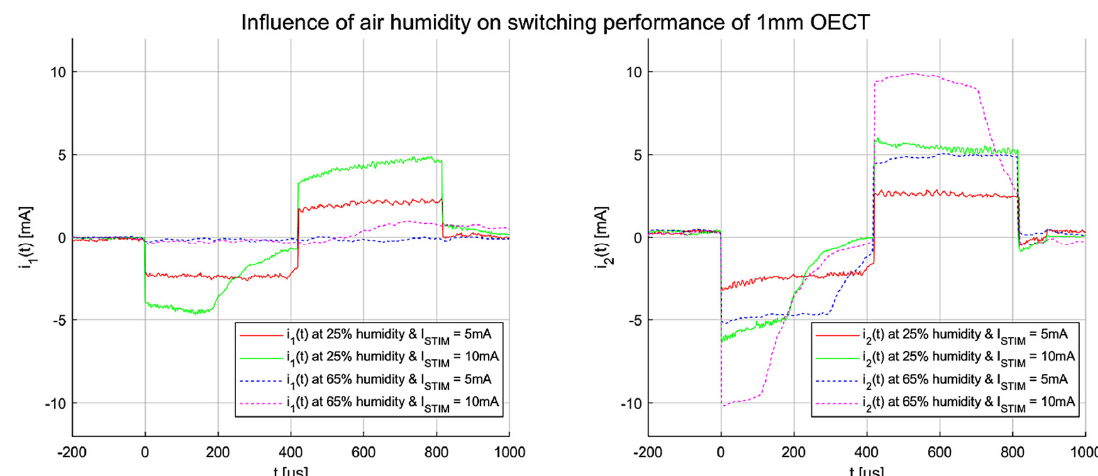
Figure 10. Effects of variations in relative humidity. The currents were measured in two parallel branches of the OECT characterization testbed. The same set of OECTs was used in these measure- ments at relative humidity levels of 25 and 65 %RH.